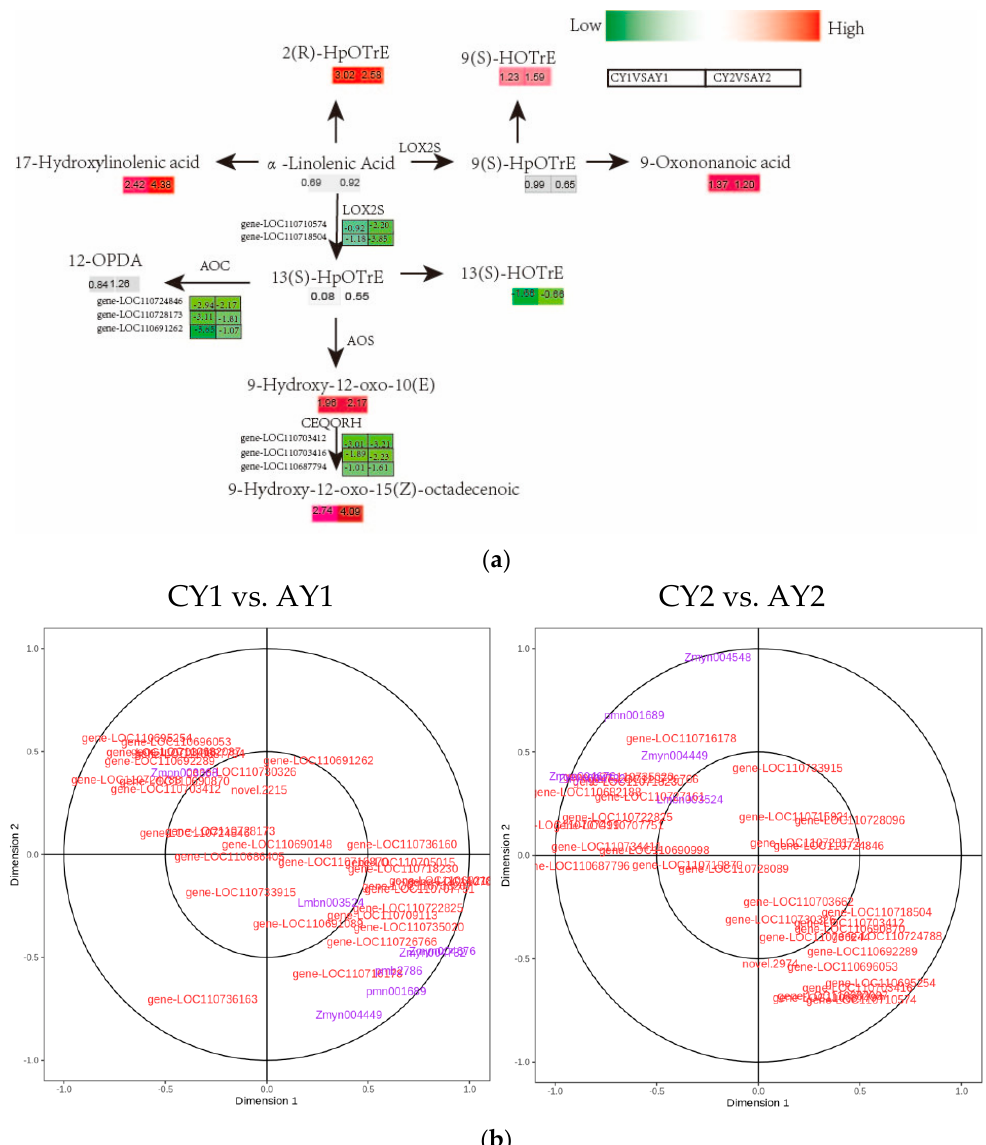
Figure 6. Comparative analysis of α -linolenic acid metabolism and related genes under freezing stress in quinoa. ( a ) Key metabolic pathways of α -linolenic acid during freezing in quinoa: gene expression levels are expressed as FPKM values followed by calculation of log2FC for different controls, and metabolite levels are expressed as log2FC values for different controls. LOX, lipoxygenase; LOS, hydroperoxide dehydratase; LOC, allene oxide cyclase; ( b ) metabolites of α -linolenic acid metabolism and the CCA of the gene, with metabolite index (purple) and gene ID (red).